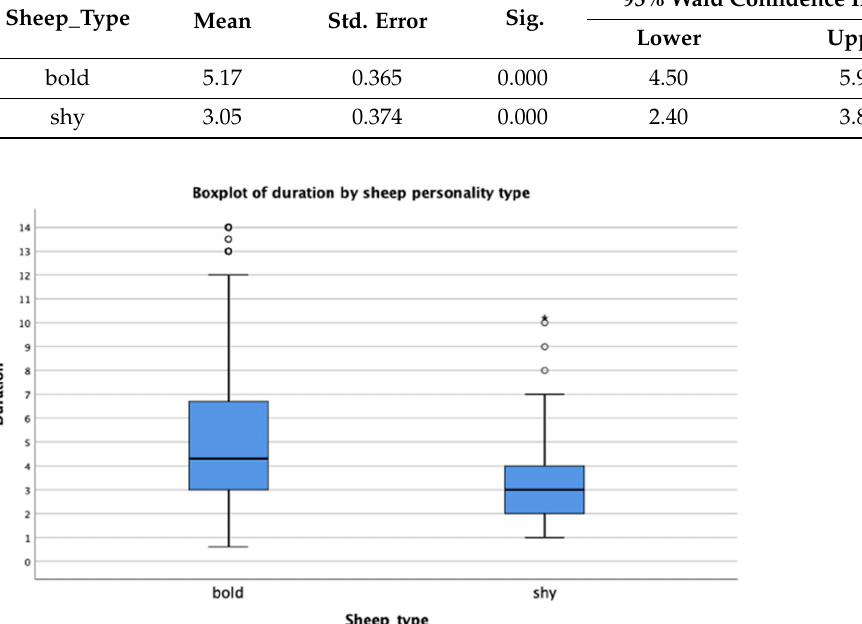
Table 6. Estimates of duration (in seconds) by personality type.